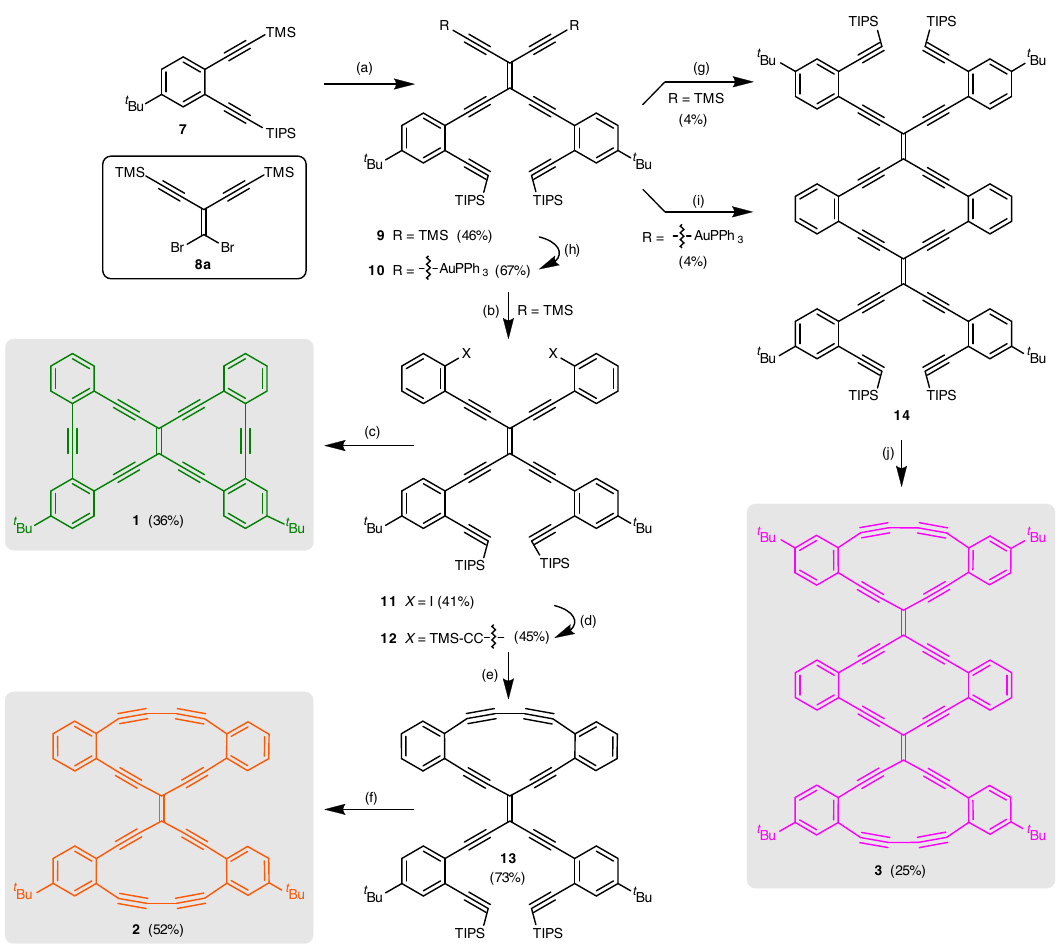
Fig. 2 Stepwise synthesis of 6,6,12-graphyne fragment 1 and Type 1 radiaannulenes 2 and 3 . Reagents and conditions: a (i) K 2 CO 3 , THF/MeOH, (ii) 8a , Cat. I, Et 3 N/THF, ))), 40 °C. b 1,2-Diiodobenzene, K 2 CO 3 , Cat. I, THF/Et 3 N/MeOH, ))), 40 °C. c (i) TBAF, THF/H 2 O, (ii) Cat. I, THF/Et 3 N. d